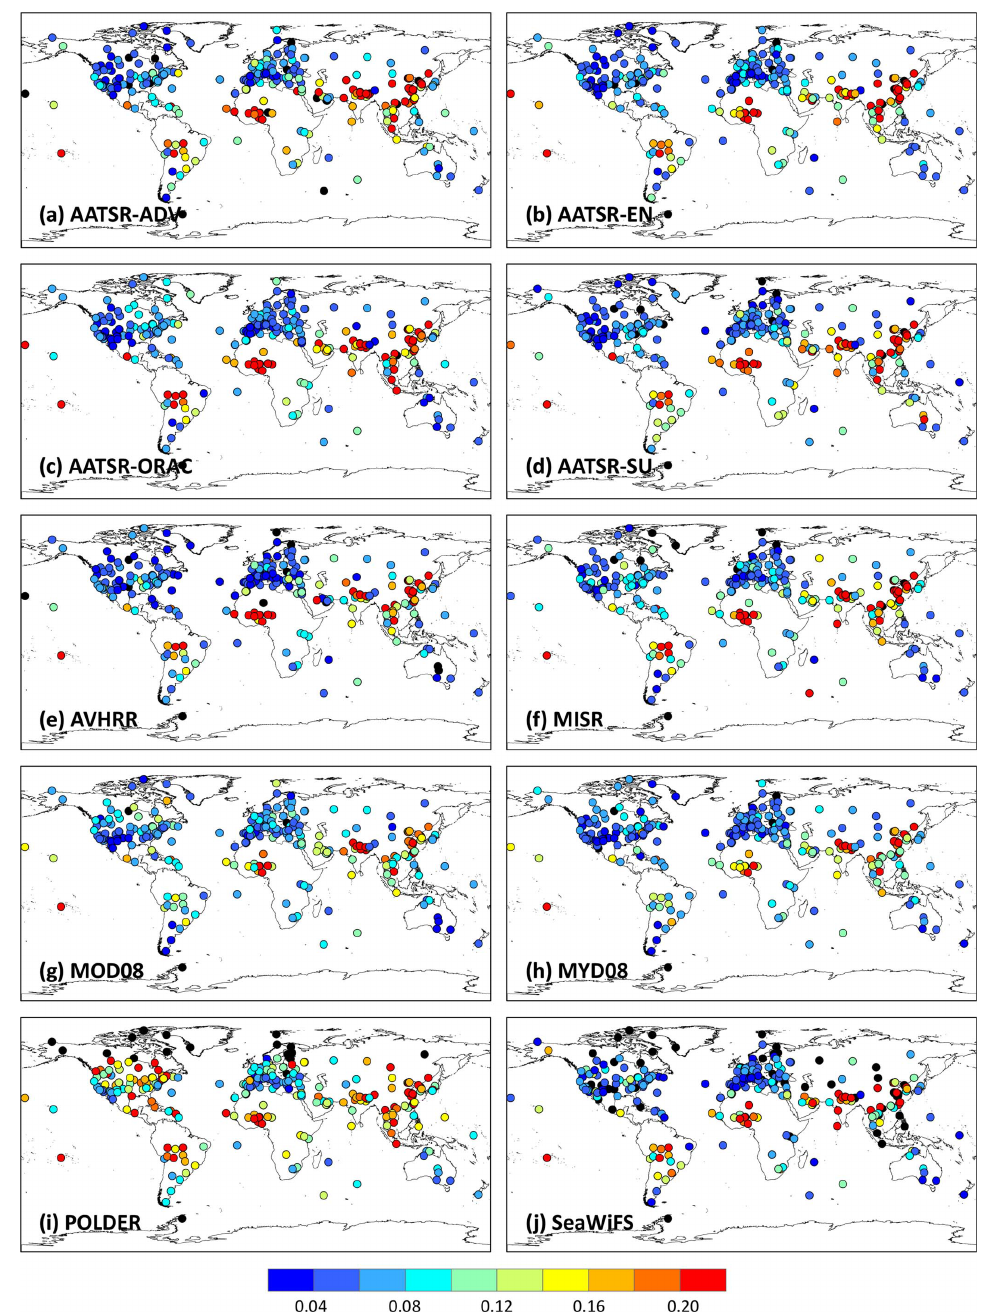
Figure 6. Same as Fig. 4 but for